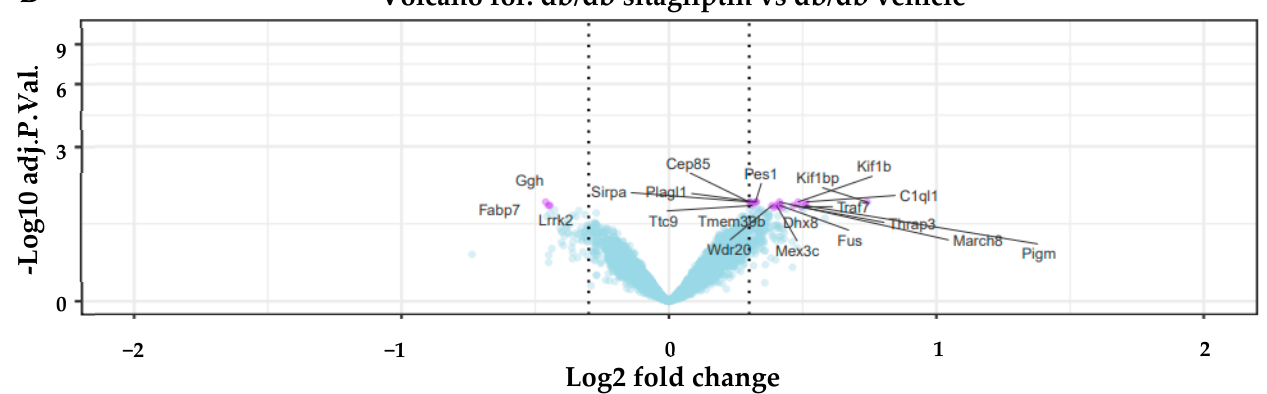
Figure 2. Most differentiated genes. ( A ) Table of top 10 genes more differentially expressed in the comparison between vehicle-treated and sitagliptin-treated mice. AveExpr is the average expression of the gene across all the arrays in log2 scale. t is a “moderated-t” statistic similar to the usual Student’s t statistic ( n = 10). ( B ) Volcano plot of db/db sitagliptin and db/db vehicle comparison. Genes are shown in purple when adjusted p -value was under 0.05, and absolute logarithmic fold change was above 0.3. Gene symbols are shown for the top 20 most significant genes ( n = 10).